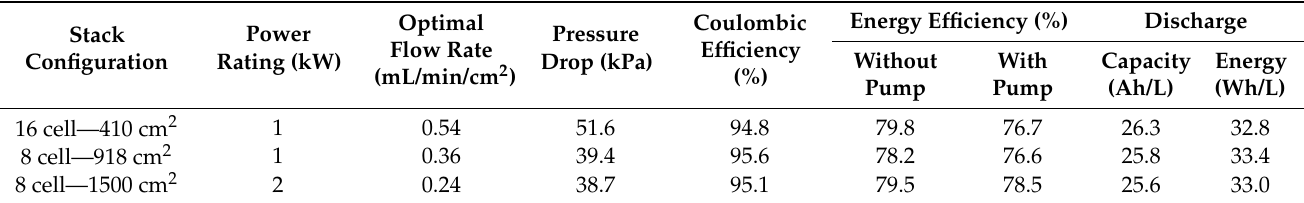
Table 4. Performance of the kW scale stacks at operating current density of 60 mA/cm 2 for optimal flow rate conditions with 8 L of electrolyte solution on each side of the stack.